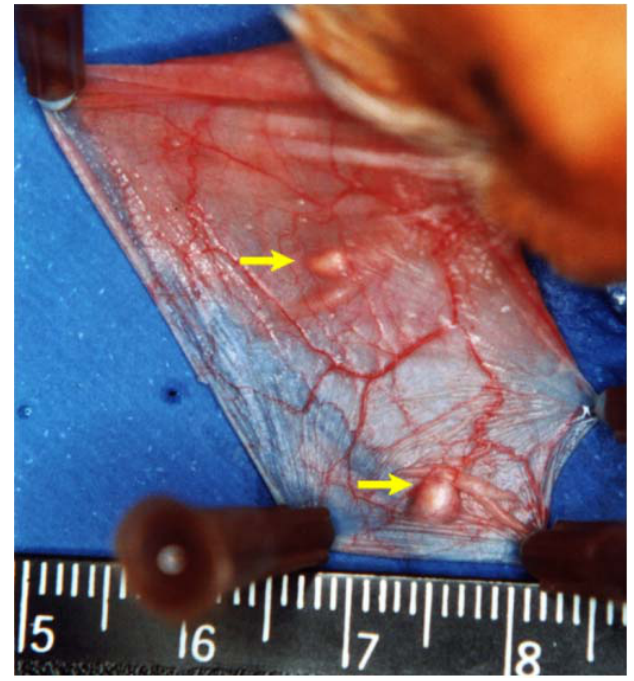
FIGURE 6 – Grafting of 2 fragments in the same cheek pouch . Macroscopic aspect at 21 days of two fragments of keloid in the same pouch